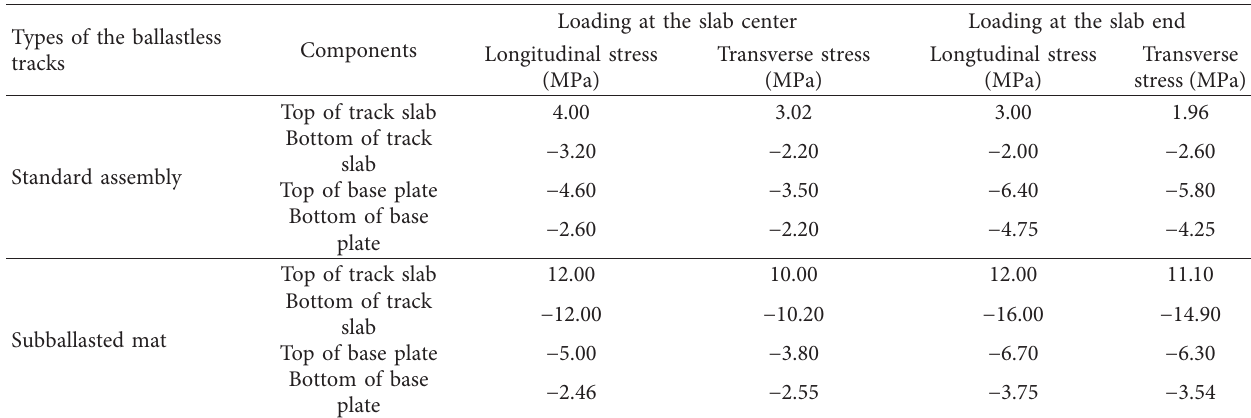
Table 4: The maximum values of steel